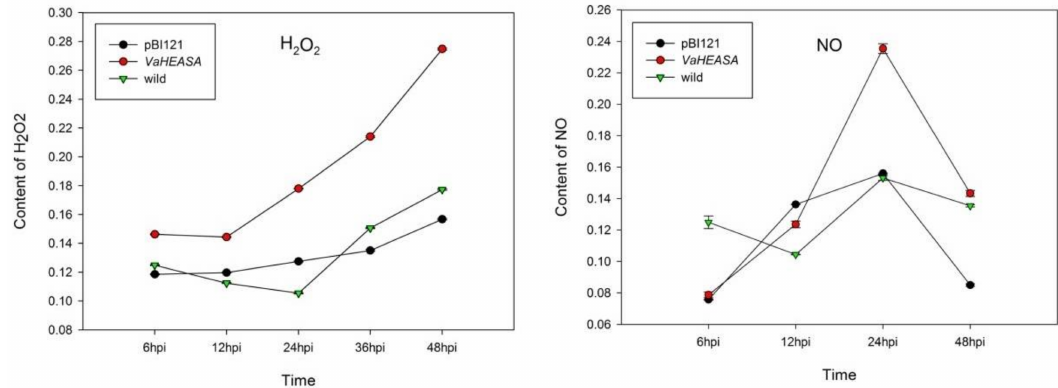
Figure 9. Analysis of H 2 O 2 and NO levels in Vitis vinifera after inoculation with Plasmopara viticola